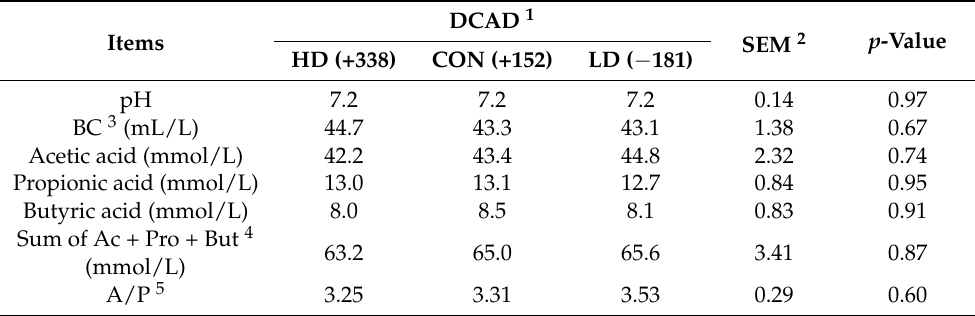
Table 2. Effect of varying dietary cation-anion difference on the rumen fermentation parameters of female